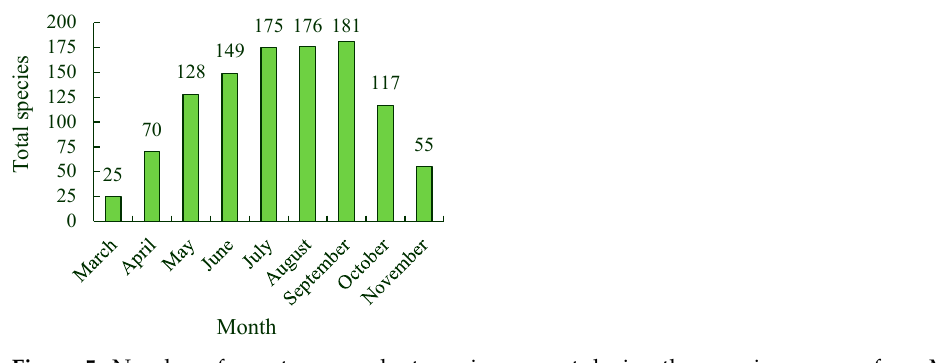
Figure 5. Number of spontaneous plant species present during the growing season, from March to November.